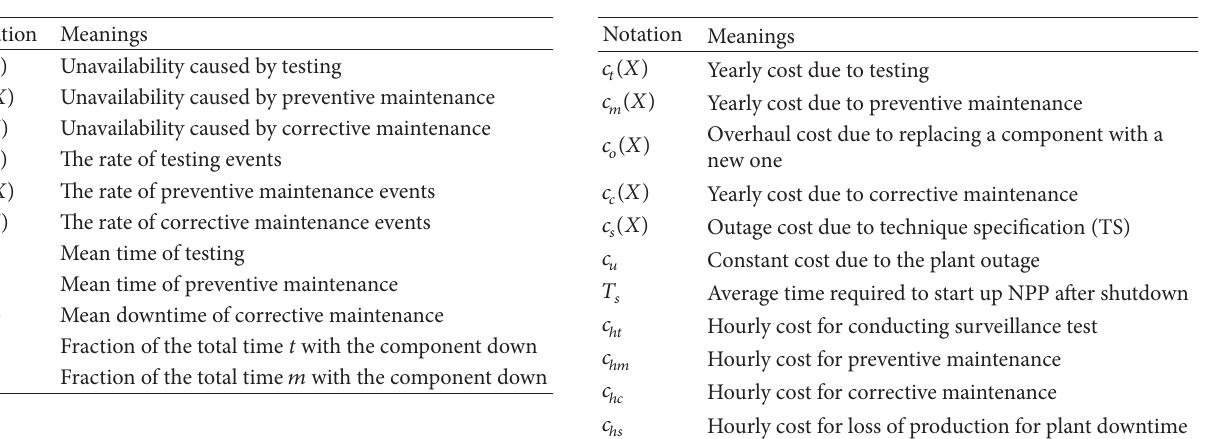
Table 2: Meanings of the notations in (6). Table 3: Meanings of the notations in